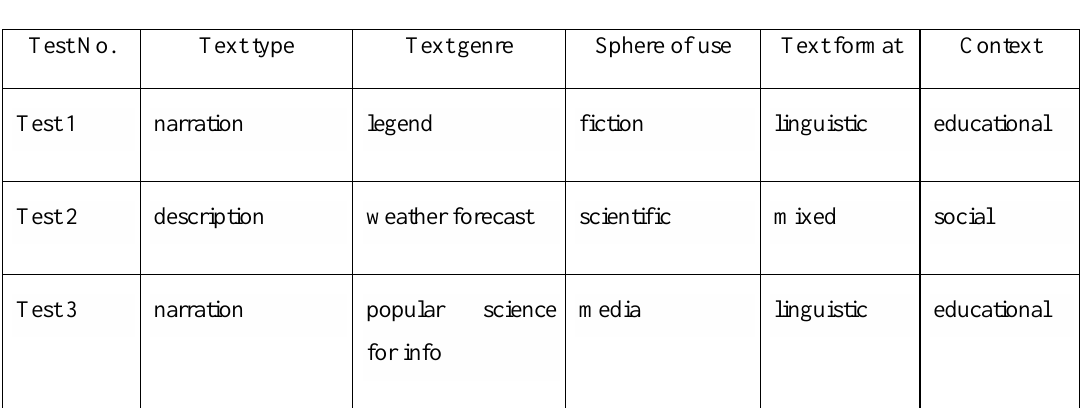
Table 1. Texts included in the test Test